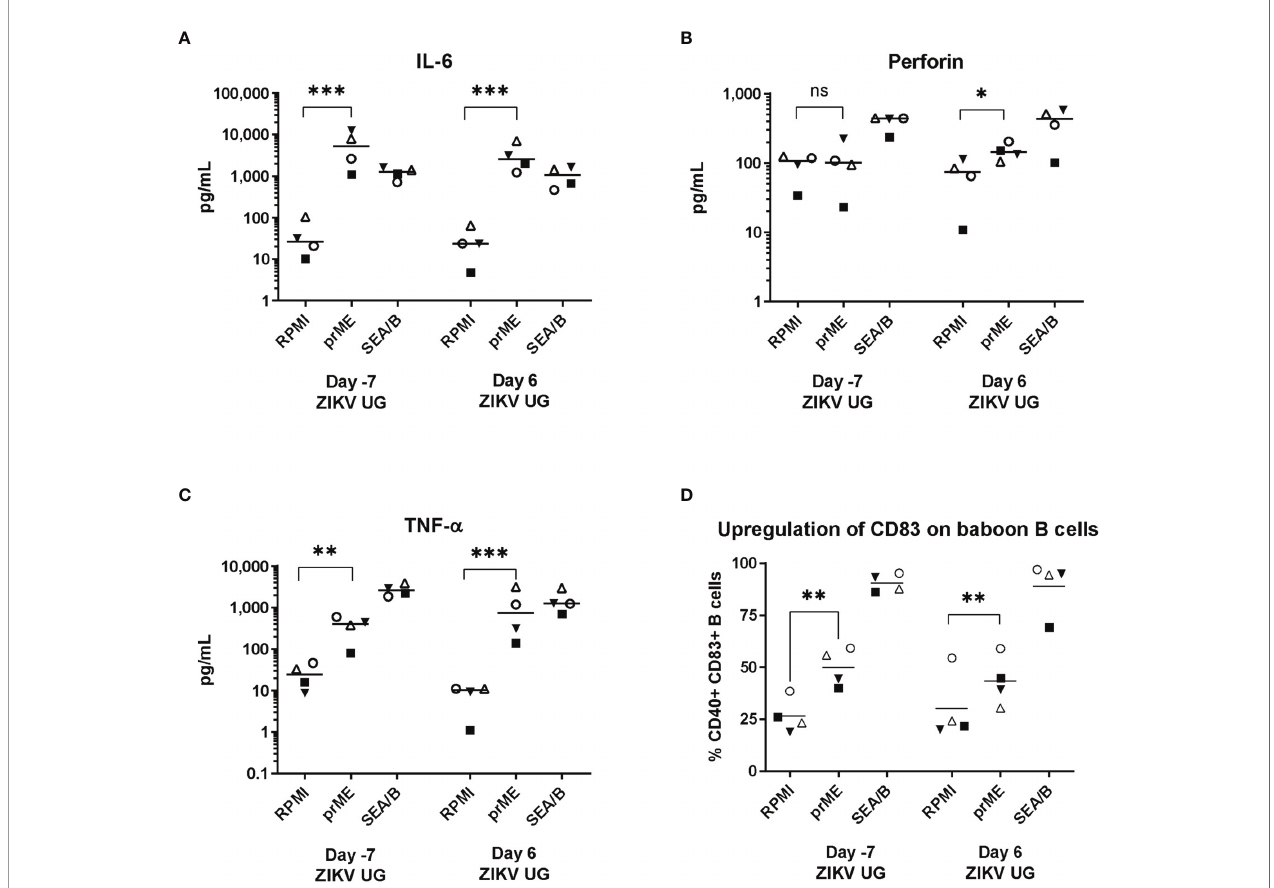
FIGURE 5 | ZIKV-speci fi c AIM assay. Baboon PBMCs were obtained a week before and a week after challenge with ZIKV UG, and were incubated with supernatant of HEK cells transduced with empty lentiviral vector (RPMI), or with supernatant of HEK cells transduced with a lentiviral vector expressing ZIKVprME protein (prME); Staphylococcus enterotoxin A and B (SEA/B) was used as positive control. After 24 hr stimulation supernatants were collected and used to measure (A) IL-6, (B) Perforin, (C) TNF- a with a Luminex assay. (D) Cells were used to measure CD83 expression on CD20 B cells. Two-tailed paired t-test. ns, not signi fi cant (p>0.05), * = p< 0.05; ** = p<0.01; *** =